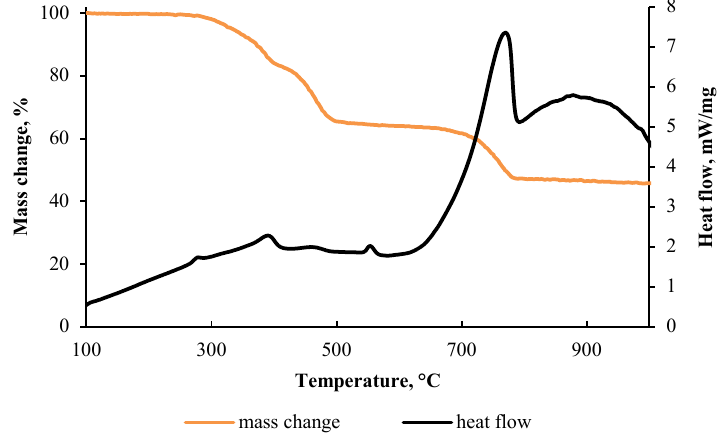
Fig. 3. Decomposition of oil shale and biomass mixture (80:20 w:w) in N 2